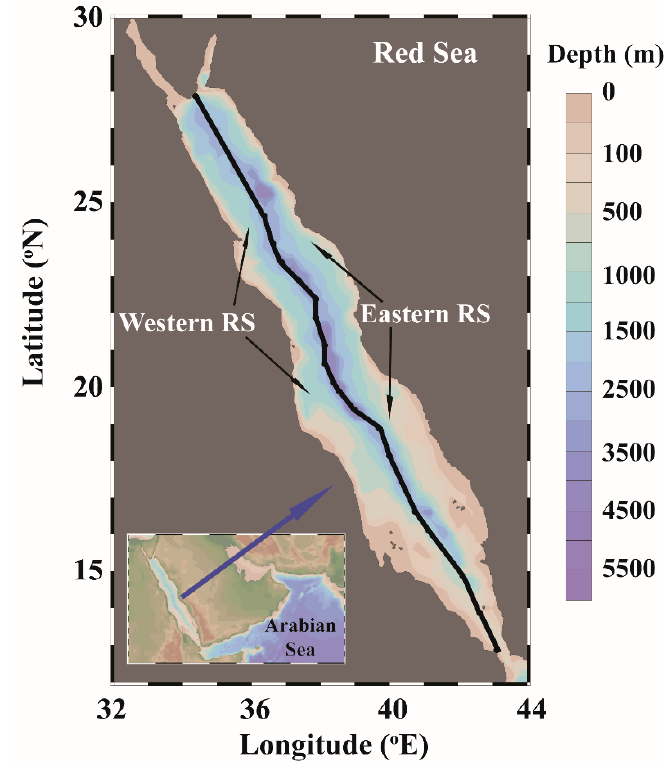
Figure 1. The geographical location and the bathymetry of the study area. The eastern and western Red Sea is marked and is separated using an axial line (black line) passing through the approximate middle of the Red Sea.